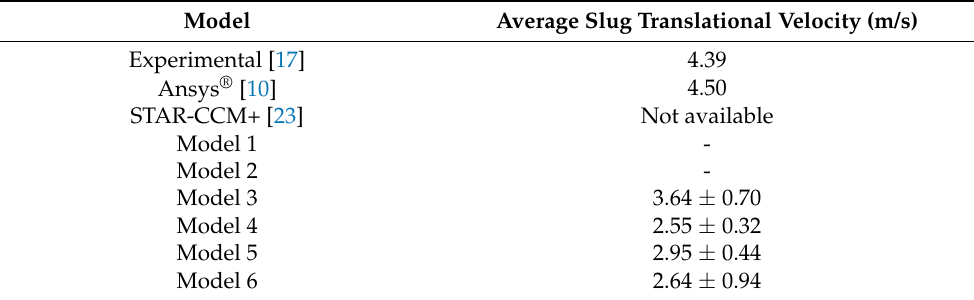
Table 5. Slug translational velocity obtained by each model within 4 s computational time.